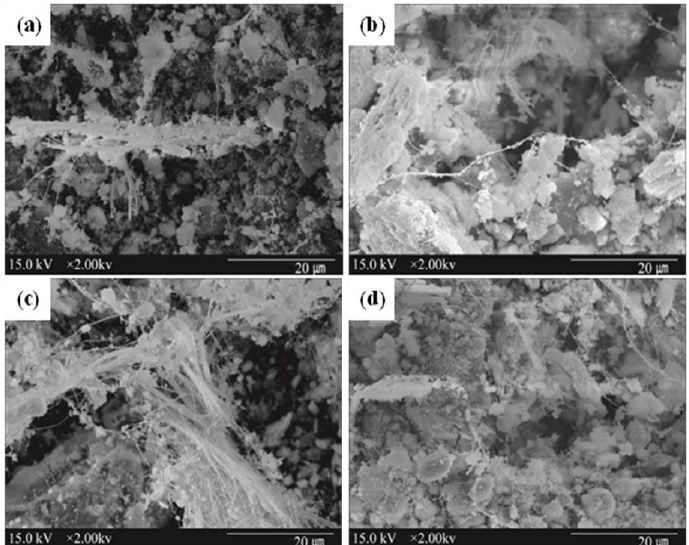
Figure 10. Scanning electron microscope (SEM) images of reacted waste slate samples obtained from carbonation tests using the 1 M NH ( a ) 20 g/L, ( b ) 50 g/L, ( c ) 100 g/L, and ( d ) 150